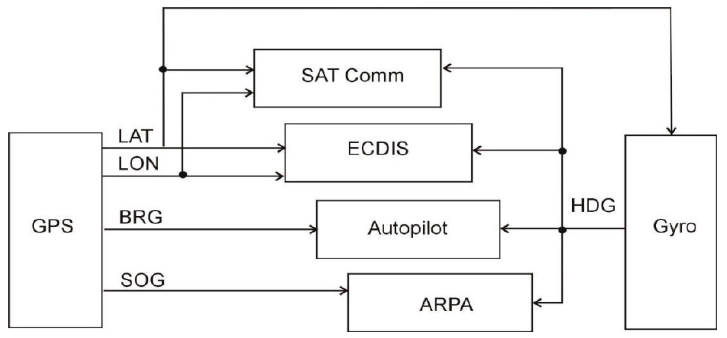
Figure 2. Proposed navigation data network scheme for the high sea passage of autonomous vessel.